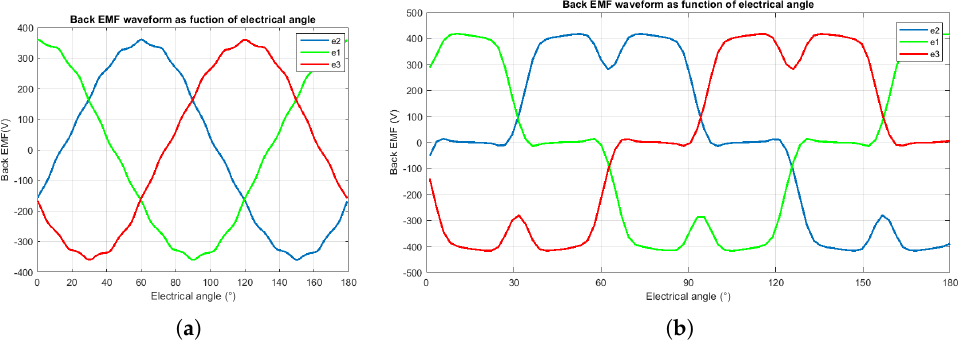
Figure 10. Comparison of back EMFs for HAPMS ( a ) and MMS ( b )